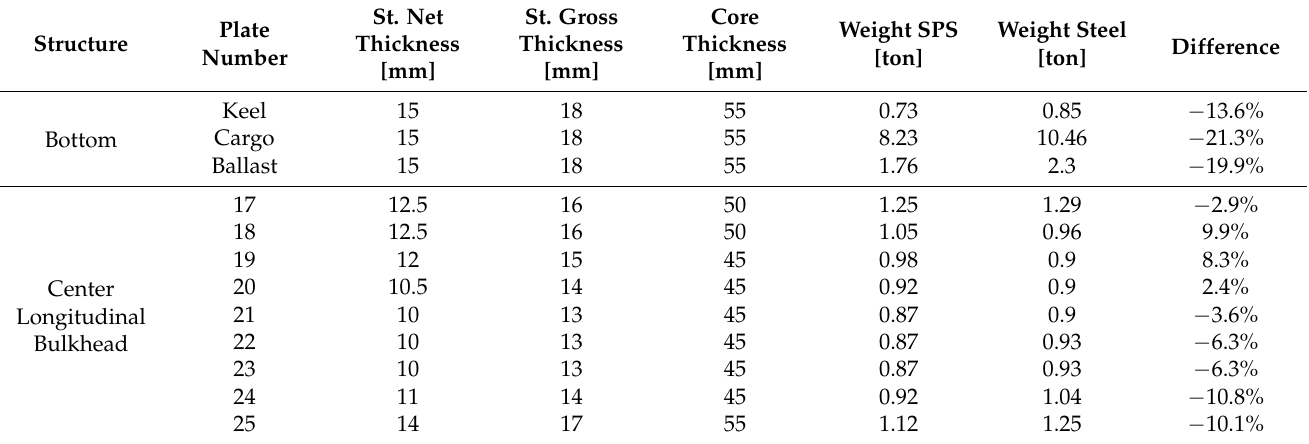
Table 5. Final distribution of the thickness for the SPS